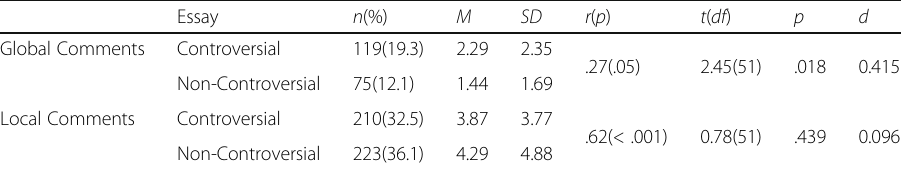
Table 3 Paired sample t -test results for the two types of comments on controversial and non- controversial